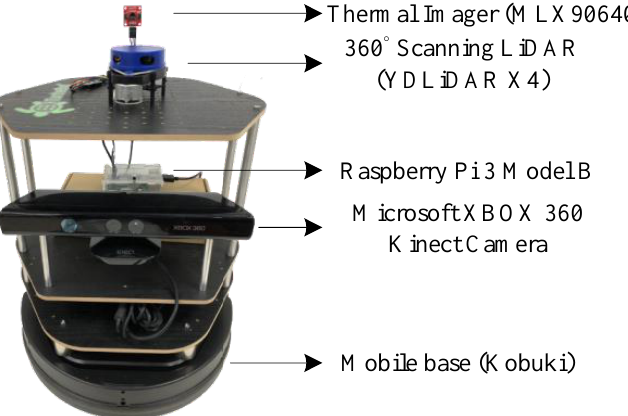
Figure 15. Autonomous mobile robot configuration. Mobile Robot